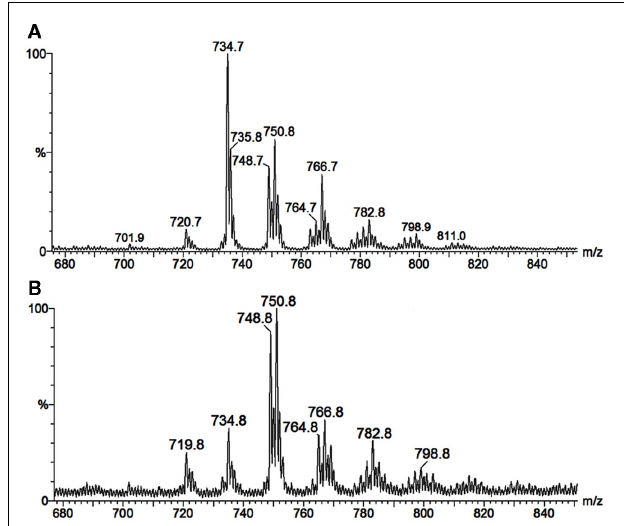
FIGURE 5 | Positive ESI-MS [M + Li] + of ceramide monohexosides from the opportunistic human pathogen Scedosporium apiospermum (A), and the saprophytic Cladosporium resinae (B).